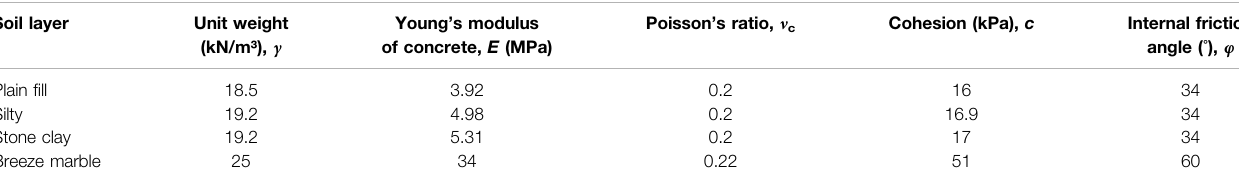
TABLE 1 | Physical and mechanical properties of in situ